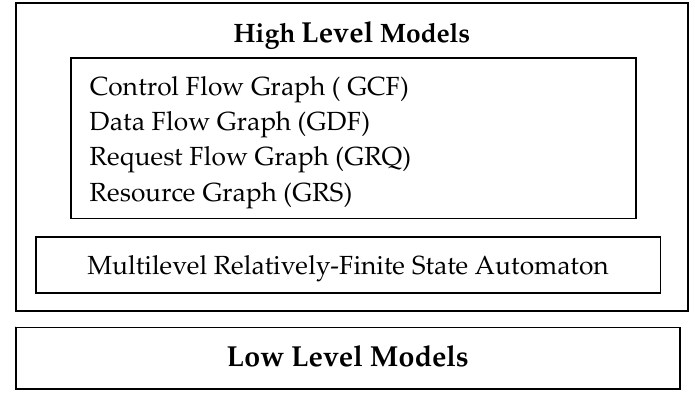
Figure 4. Models system structure.